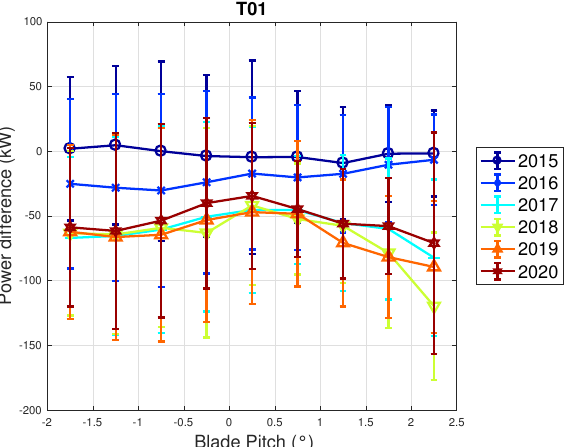
Figure 10. Binned blade pitch–power (right) in Region 2 1 / 2 for T01 in WF2: the curves are reported in the form of difference with respect to the year